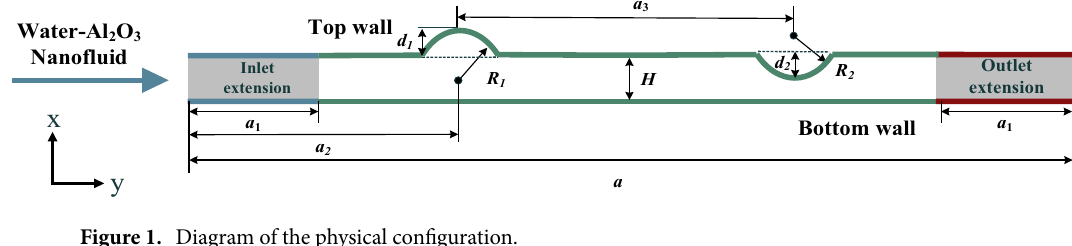
Figure 1. Diagram of the physical